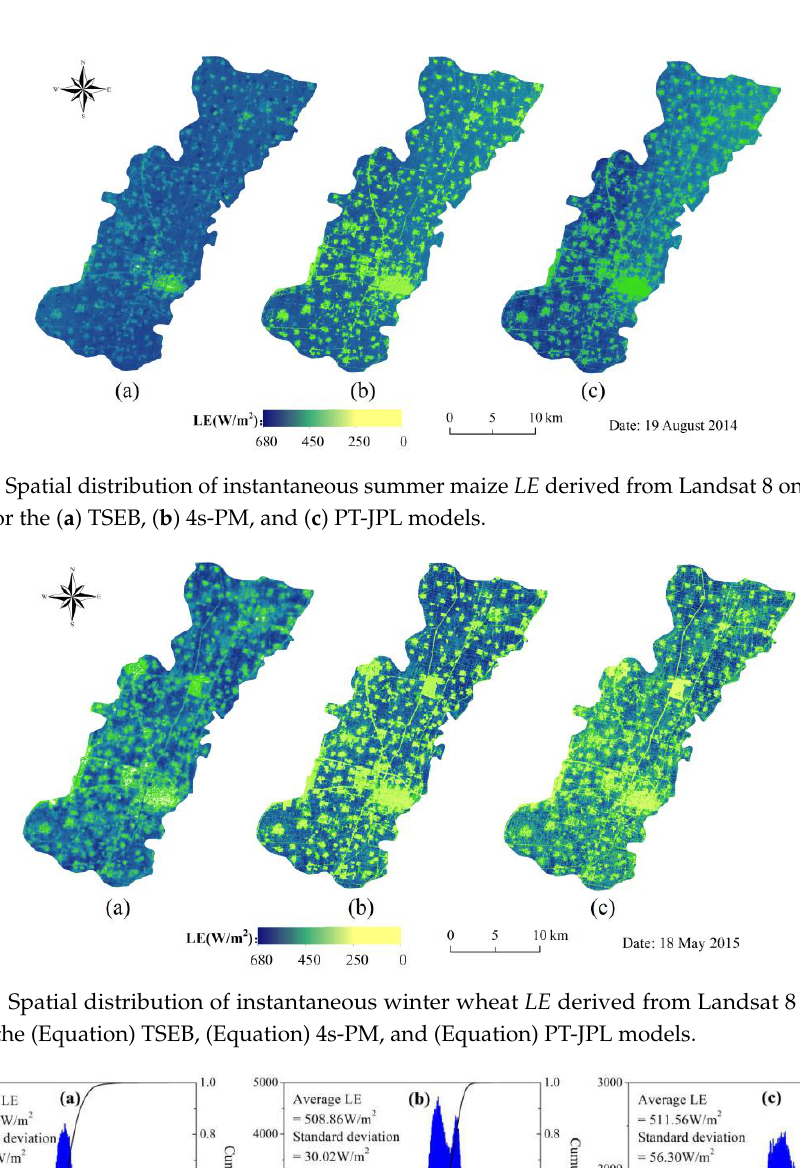
Table 2. Statistics of the three models derived Latent heat flux for maize and wheat. Crop Observed Averaged (W/m 2 )